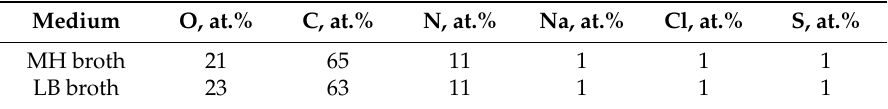
Table 2. Elemental compositions of the bacterial culture media. Medium O, at.%